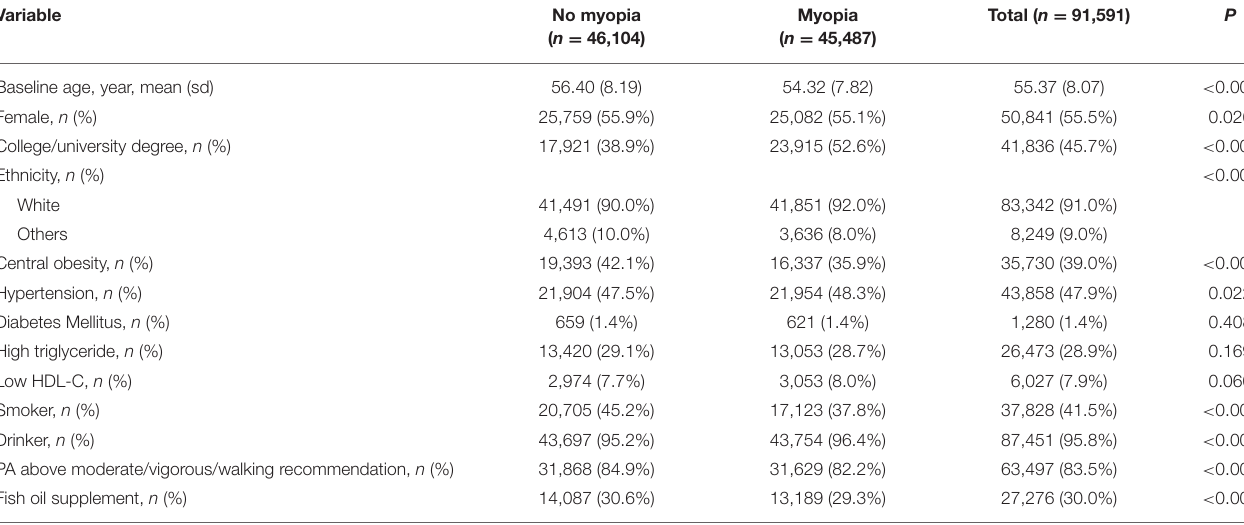
TABLE 1 | Baseline characteristics of participants with and without myopia.